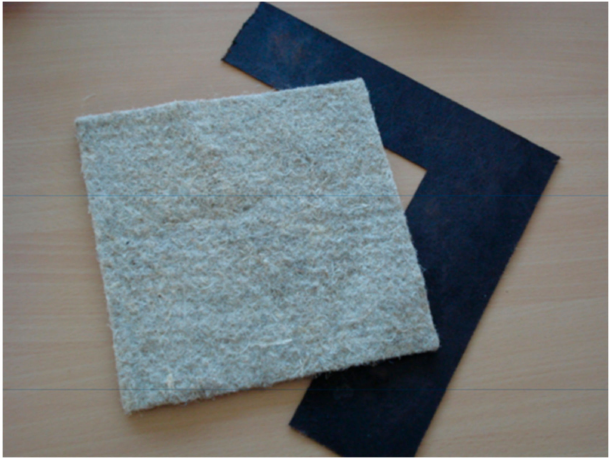
Figure 17. A nonwoven web of hemp fibers and the composite obtained by impregnation with a tannin–furanic